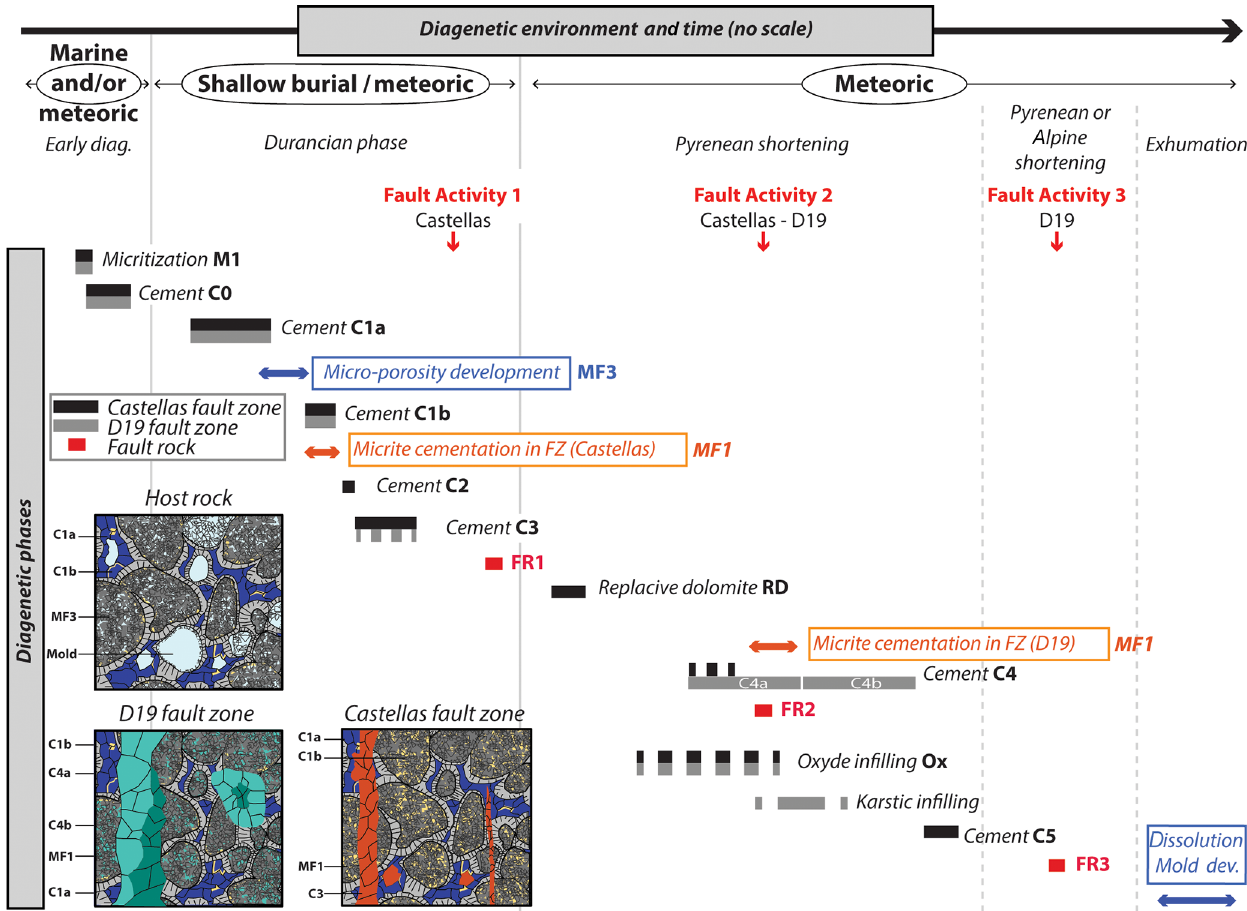
Figure 7. Paragenetic sequence of the both fault zones (black: Castellas; grey: D19) with microporosity development (blue), cementation (orange), and fault zone activation events